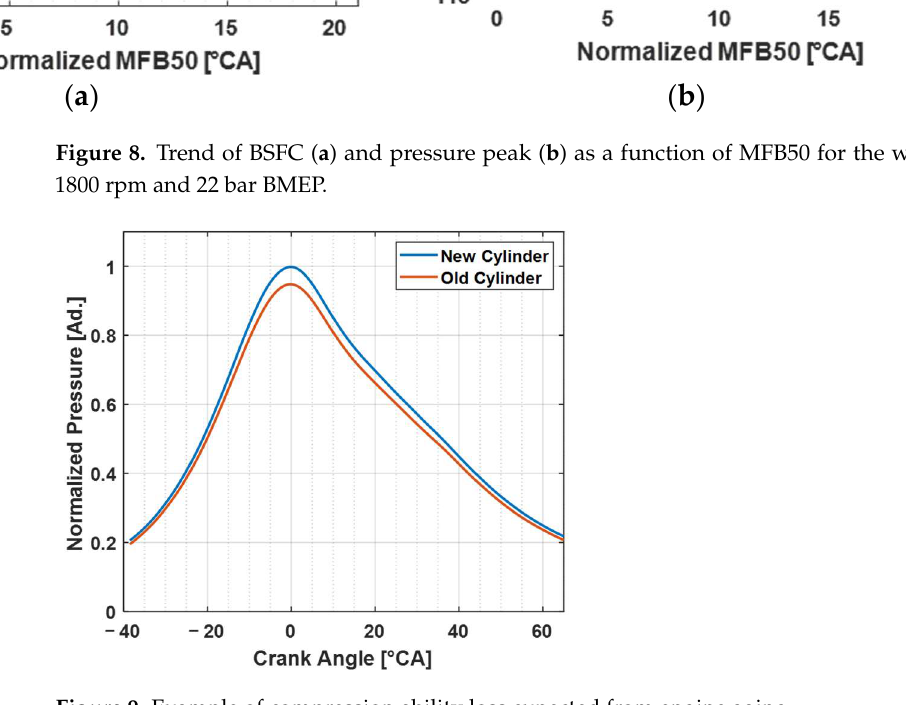
Figure 9. Example of compression ability loss expected from engine aging. This means that the same MFB50 setting would lead to lower peak pressures. There- fore, advancing the MFB50 Limit Map values, it would be possible to partially recover the performance loss due to aging. For this reason, in the proposed control approach, the MFB50 target for all the cylinders is determined as the higher between optimal and limit values, the latter being continuously adapted cylinder by cylinder to the actual state of health of the engine.